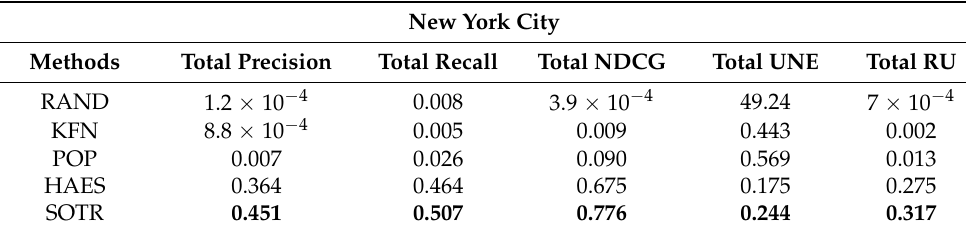
Table 6. The experimental results for New York City after setting the value of Sru = 4, Sn = 3, Ns =